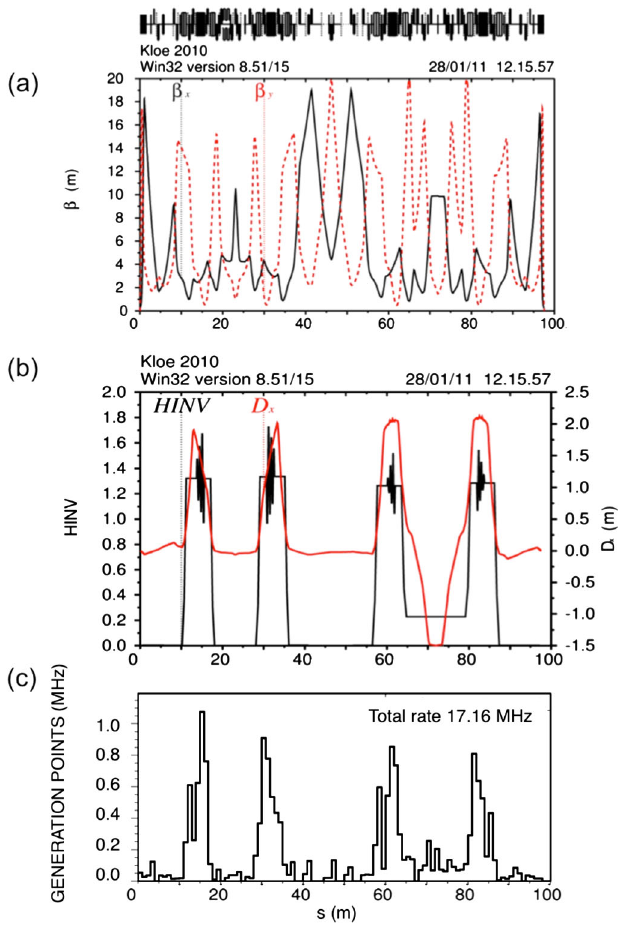
FIG. 3. Present crab-waist optics for the KLOE-2 run, the interaction point is at s ¼ 0 m ; (a) (cid:6) functions; (b) H -invariant and horizontal dispersion (black and red curves); (c) corresponding locations of Touschek scattering occurrence of particles that are eventually lost along the